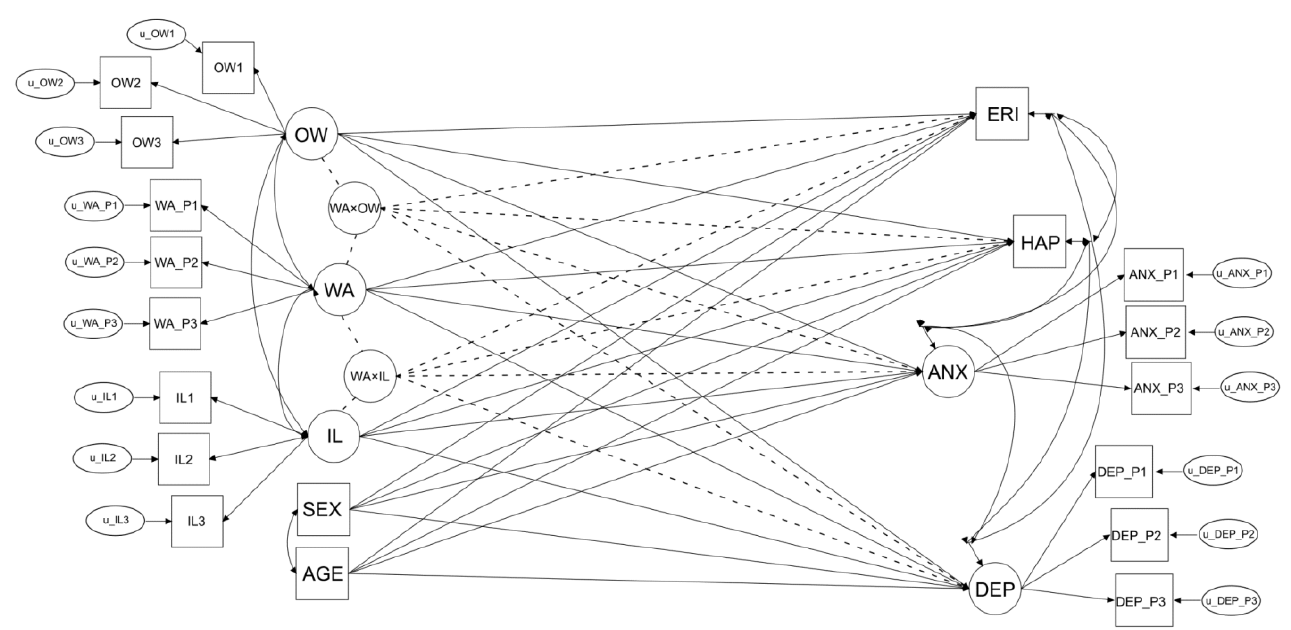
Figure 1. Structural equation model for the prediction of effort/reward imbalance (ERI); happiness (HAP); anxiety (ANX); and depression (DEP) using gender (SEX); age (AGE); intrusive leadership (IL); off-time work (OW); workaholism (WA); and the interactions of WA with IL (WA × IL) and OW (WA × OW). Ovals represent latent variables; rectangles represent observed variables. Solid lines represent direct effects or correlations; dotted lines represent interaction (moderation) effects. Observed variables whose name contains “_P” denote parcels of observed variables (see text for more details). Latent variables whose name contains “u_” denote uniquenesses (or residual variances) of the corresponding observed variables.